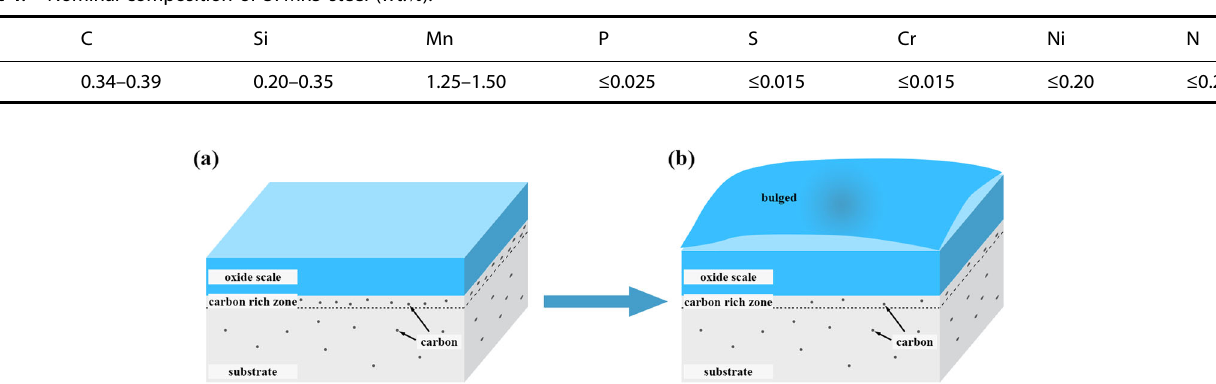
Fig. 7 Schematic diagram of the microstructure evolution of 37Mn5 steels after oxidation in air at 700 °C. a Decarbonization process at high temperature. b Defects morphology.